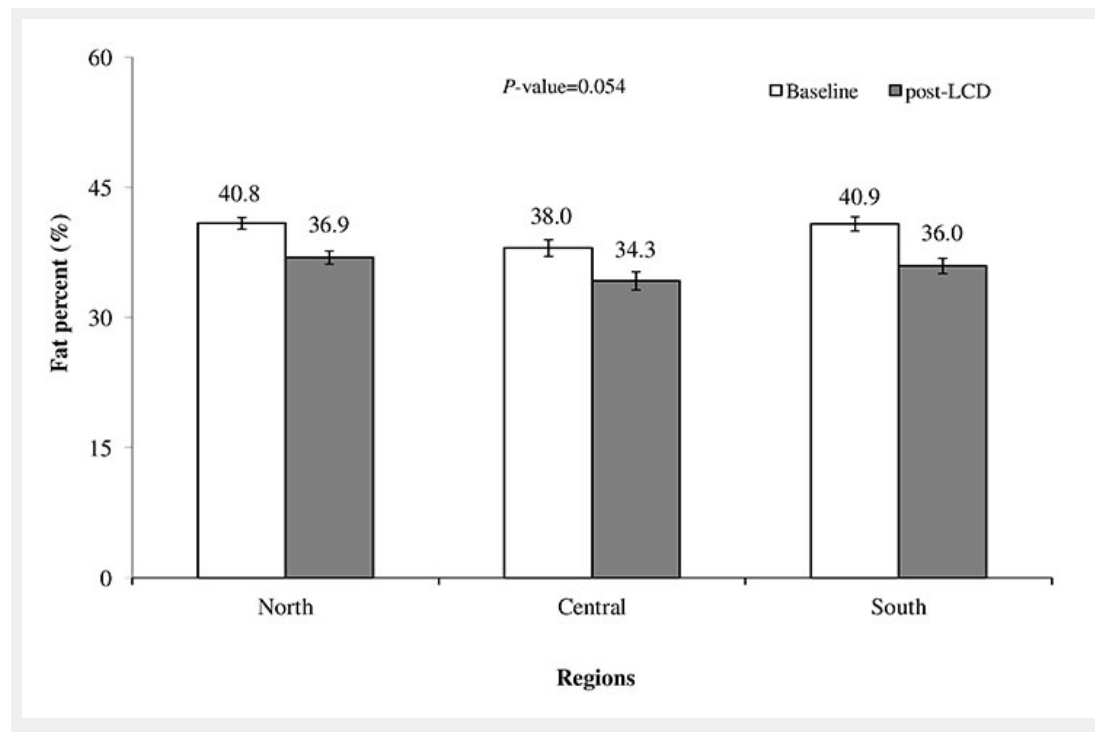
Figure 2 Body fat percentage over the LCD period in the DiOGenes participating regions, 2006–2007. LCD = low-calorie diet; bars (I) indicate 95% confidence intervals; comparisons in body fat percentage changes between regions were performed using analysis of covariance, with age, gender, baseline body fat percentage and LCD duration (weeks) as